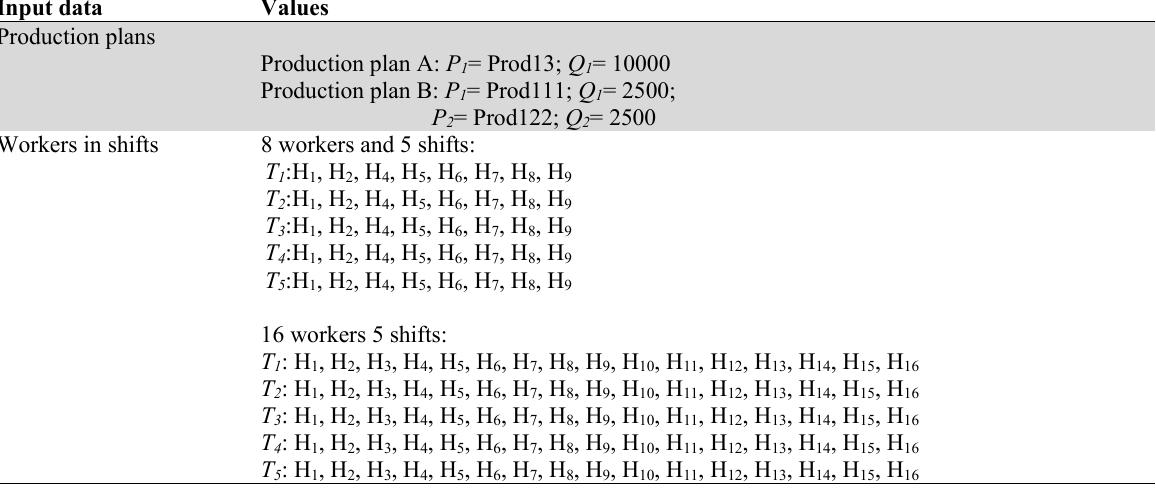
Illustrative test problem data for adjusting 𝛼 parameters Input data